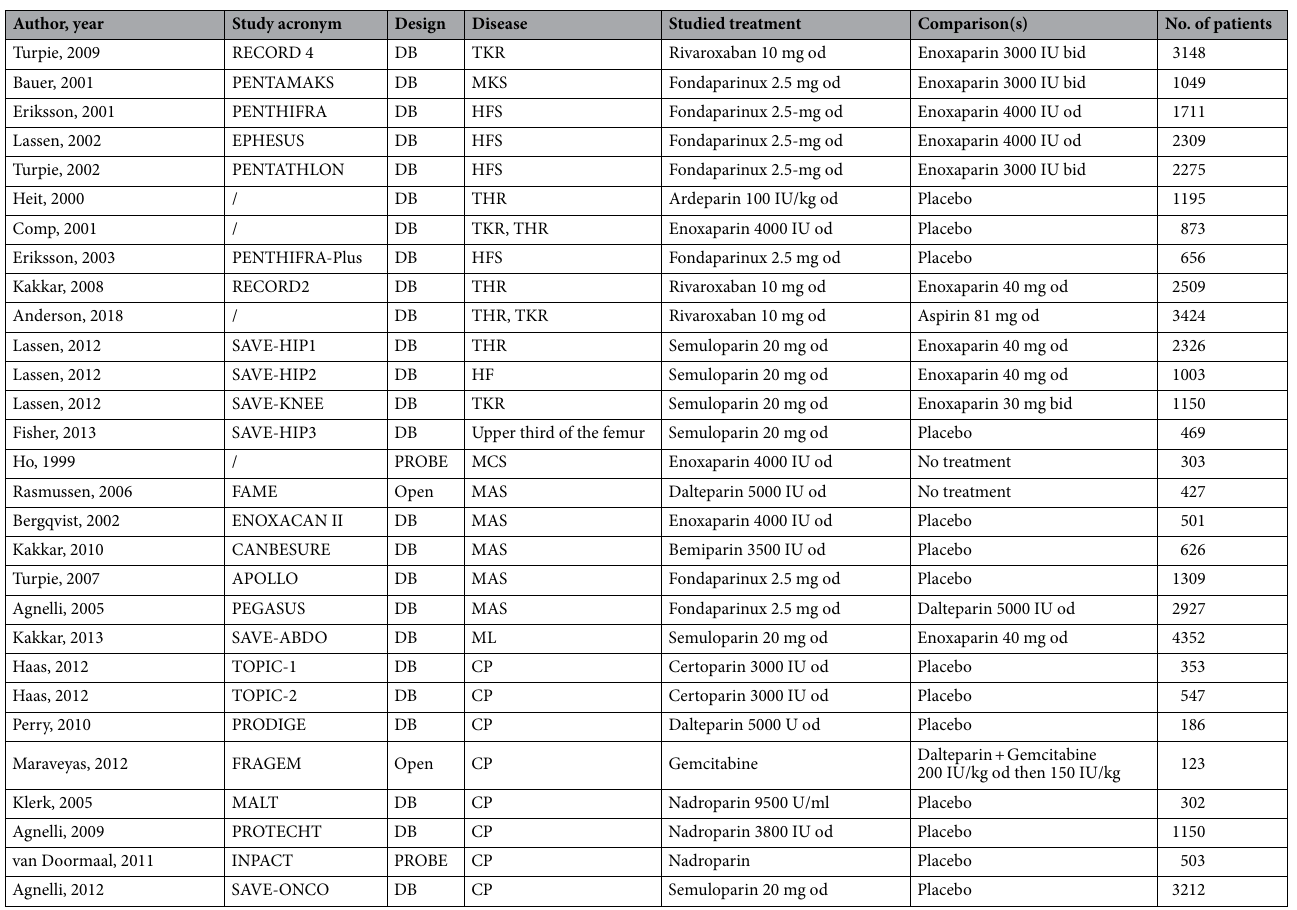
Table 1. Studies characteristics and main antithrombotics for all the studied diseases. AF atrial fibrillation, VTE venous thromboembolism, DVT deep vein thrombosis, PE pulmonary embolism, CHF congestive